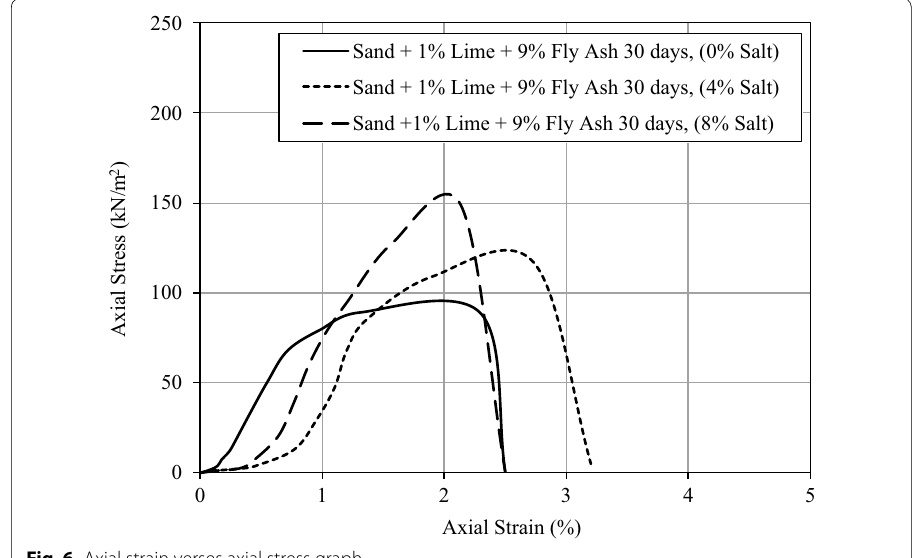
Fig. 6 Axial strain verses axial stress graph